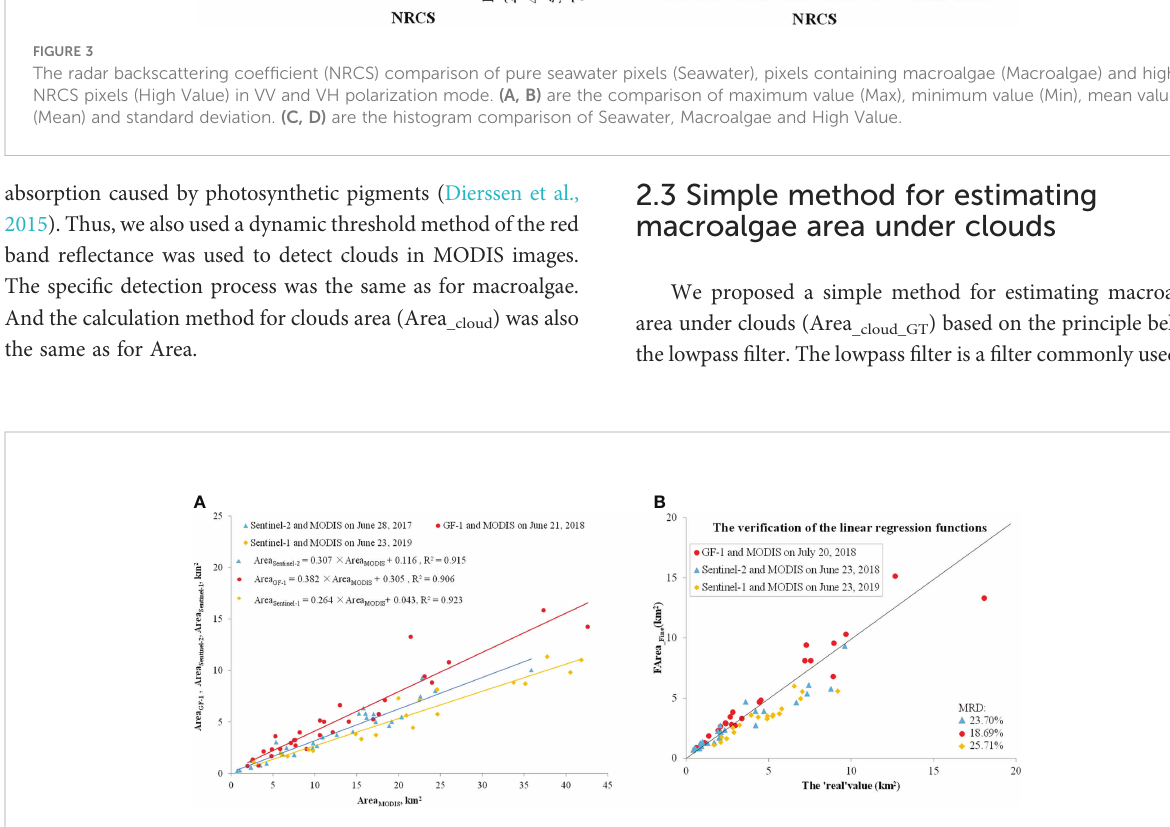
FIGURE 4 (A) Comparison in the macroalgae coverage areas derived from optical images of MODIS, GF-1, Sentinel-2 and Sentinel-1, i.e., Area MODIS , Area GF-1 , Area Sentinel-2 , Area Sentinel-1 , respectively. (B) The veri fi cation of the linear regression functions in Figure (A) . The ‘ real ’ values are the macroalgae area detected by fi ne resolution images (GF-1, Sentinel-2 and Sentinel-1), and FArea_ Fine is the macroalgae fi tted area converted by the macroalgae area detected by MODIS images based on the linear regression functions. MRD is the mean relative difference between FArea_ Fine values and the ‘ real ’ values. The black line in fi gure is the 1:1 line.